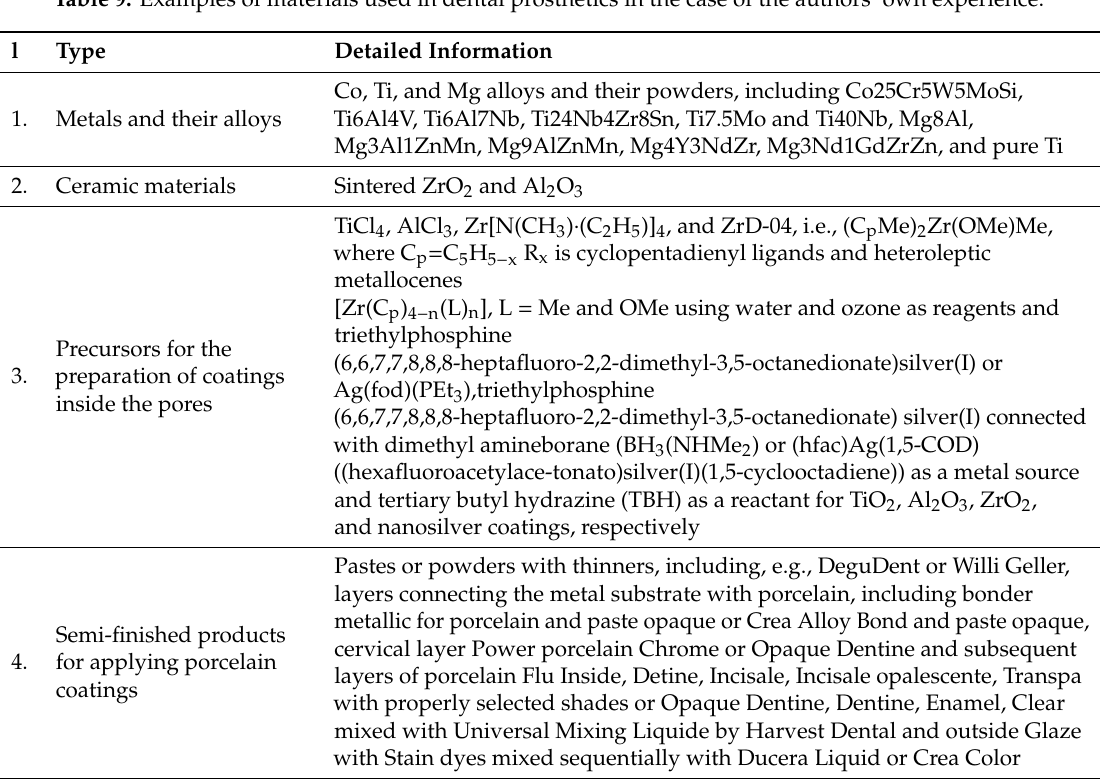
Table 9. Examples of materials used in dental prosthetics in the case of the authors’ own